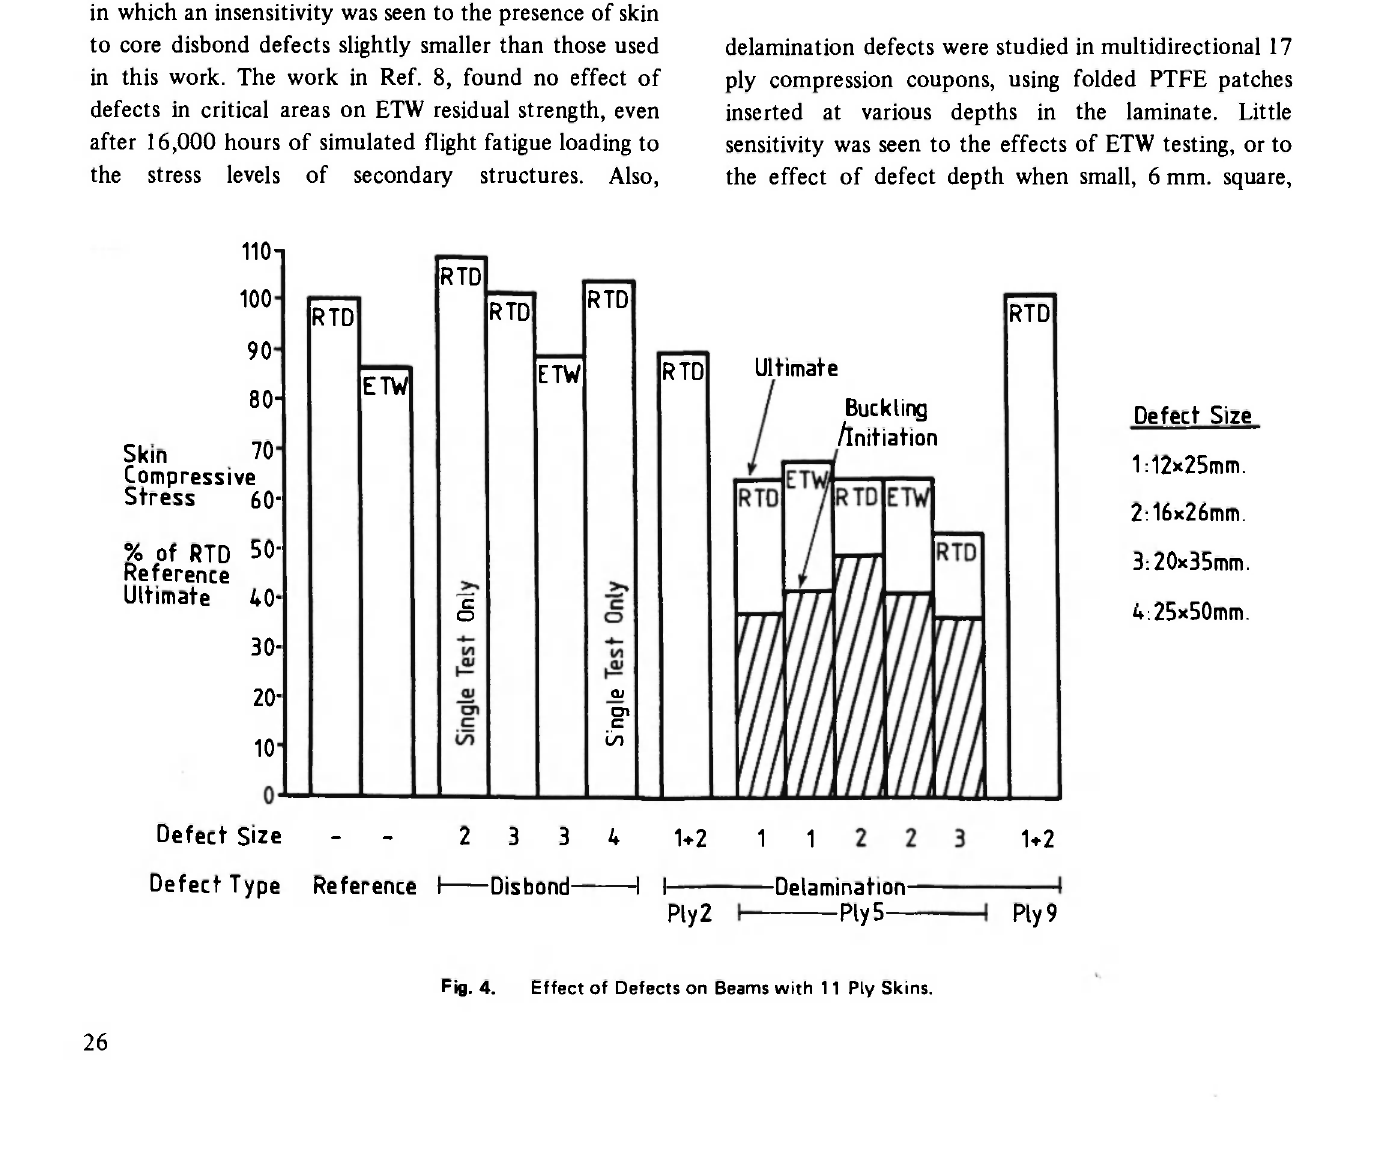
Fig. 5. Effect of Defects on Beams with 7 Ply Skins.